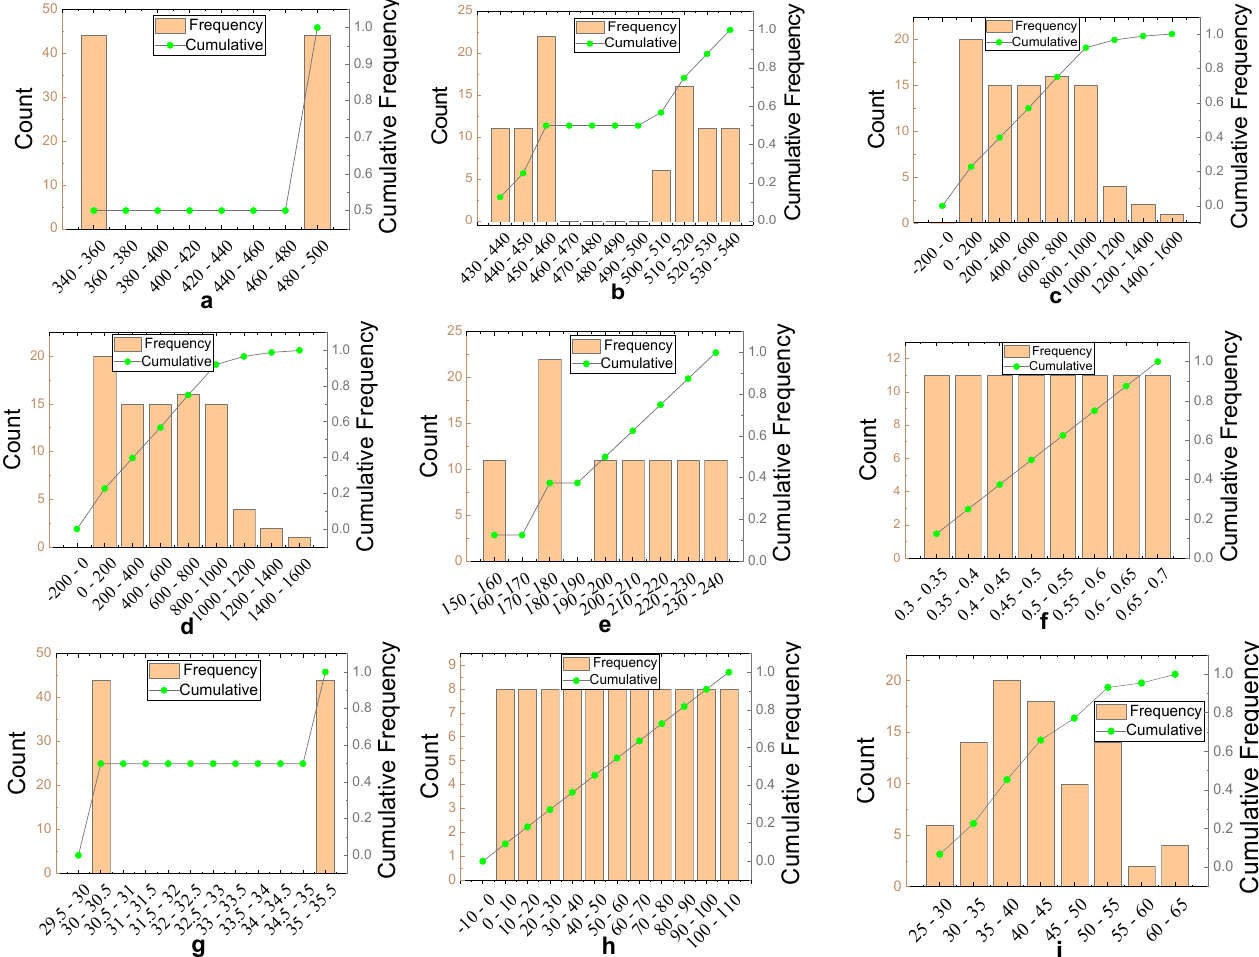
Figure 17. Histogram of variable frequency distribution.{( a ) C (Kg/m 3 ); ( b ) S (Kg/m 3 ); ( c ) NCA (Kg/m 3 ); ( d ) RCA (Kg/m 3 ); ( e ) Water (Kg/m 3 ); ( f ) W/C; ( g ) SR (%); ( h ) RRCA (%); ( i ) CS (MPa)}. Table 6. back propagation neural network ( BPNN) model training parameters.